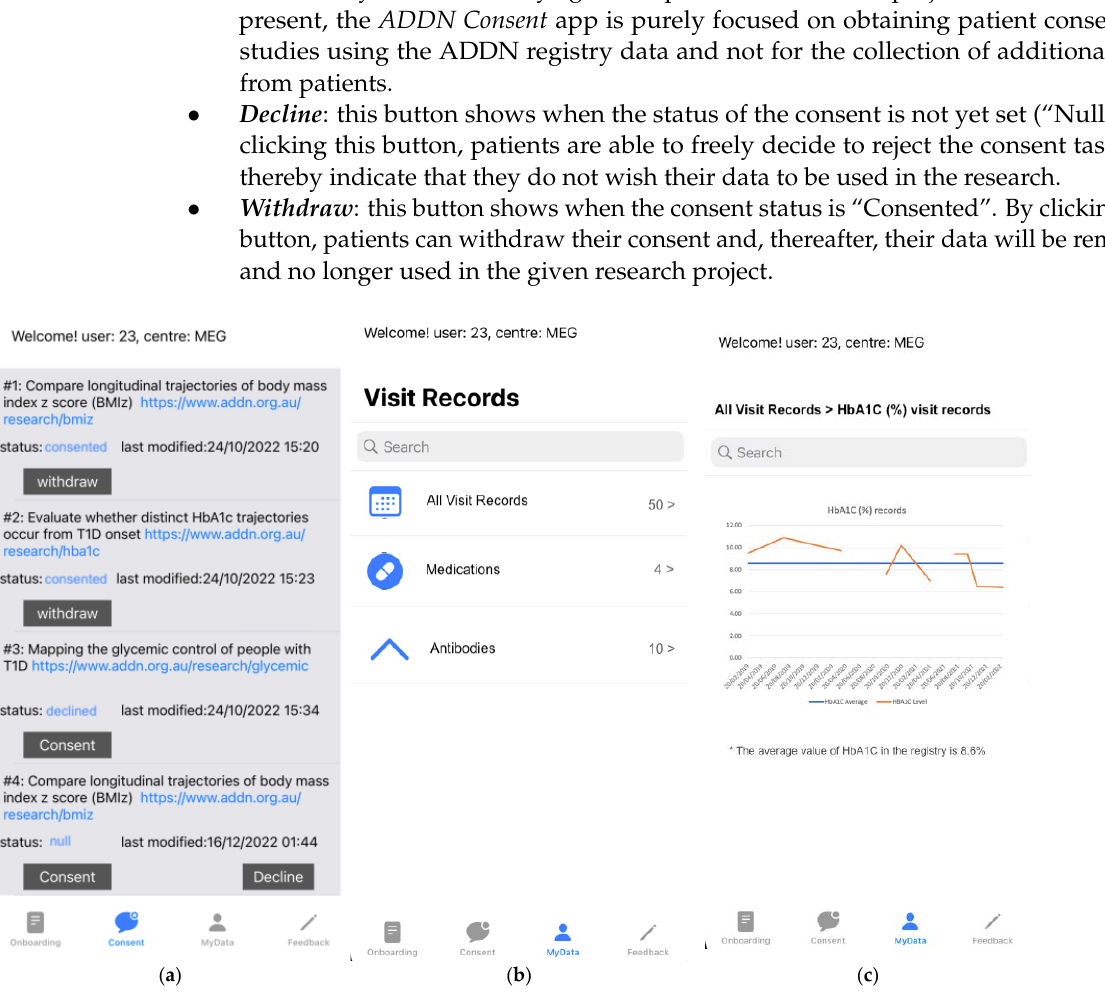
Figure 4. Screenshots of the ADDN Consent application. ( a ) Dynamic consent tasks. ( b ) Patient view of their data. ( c ) Patient view of their HbA1C data in visit records . Error! Reference source not found. summarises the four consent statuses and the actions that the patient can perform depending on the consent status. Table 1. Consent status and associated actions.